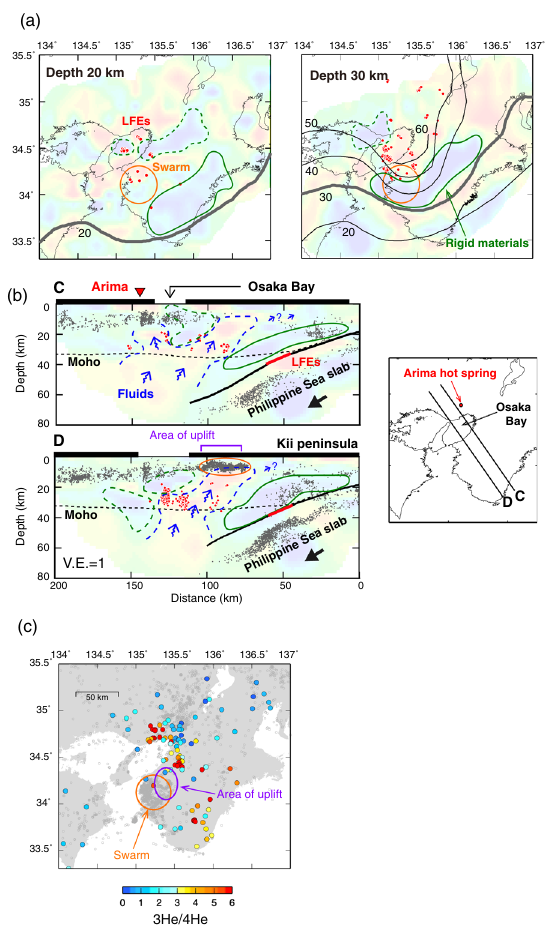
Fig. 11 Interpretation of the velocity structures a for two depth slices and b along two across-arc vertical cross sections. The Wakayama swarm is shown by an orange circle in the depth slices and an orange ellipse in the vertical cross section. Green areas are interpreted to be rigid and impermeable materials. See the text for further details. c Distribution of the air-corrected 3 He/ 4 He ratios (Sano and Wakita 1985; Matsumoto et al. 2003; Umeda et al. 2007; Sano et al. 2009; Morikawa et al. 2016). The purple ellipse denotes an area of uplift at > 4 mm/year (Yoshida et al.